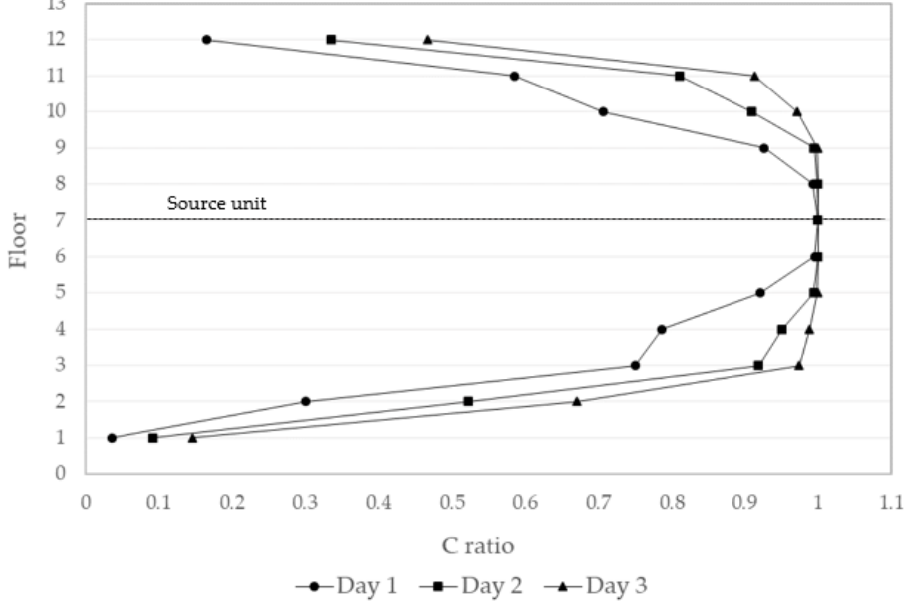
Figure 12. Central concentration in units with different pressures (day 3, 1000 ppm).